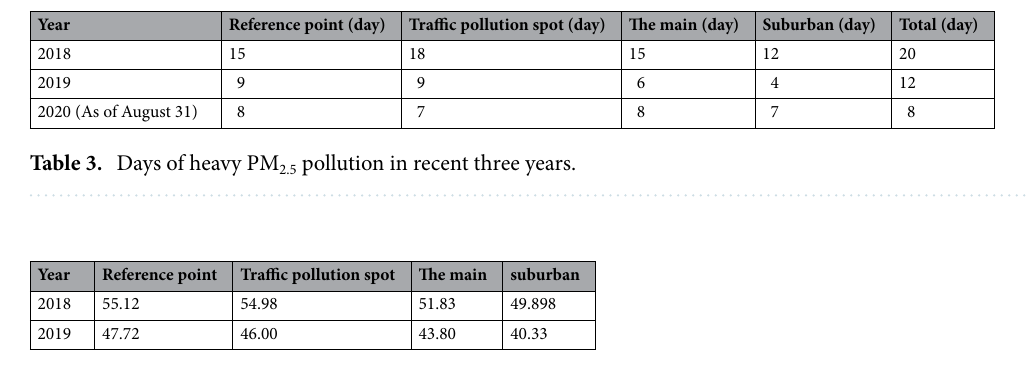
Table 4. The annual average value of PM 2.5 at each classified monitoring